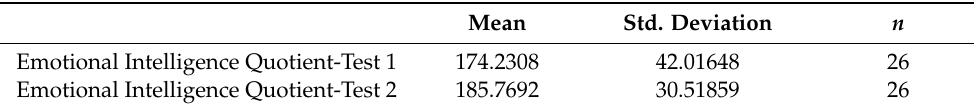
The difference between the mean result for pre-test/Trial-I scores for Group I and for post-test/Trial-2 scores for Group I was statistically significant F (1.25) = 5.362, p = 0.29, partial η 2 = 0.177 (see Table 9). Table 9. Mean results for emotional intelligence quotient for the ANCOVA model for Group I pre-test and post-test measurements. Std. Deviation